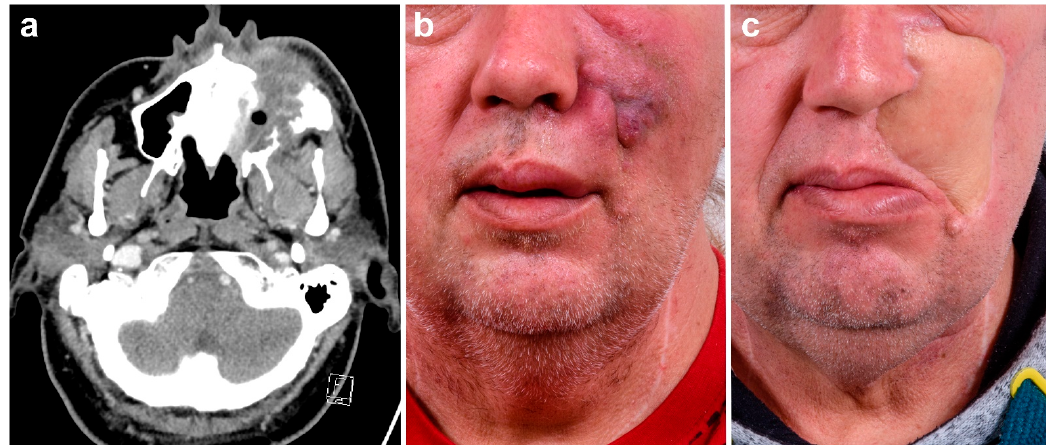
Figure 3. Male patient with recurrent squamous cell carcinoma of the left-sided maxilla with infiltration of the maxillary sinus and facial skin. ( a ) CT scan depicting the infiltration of the paranasal sinus and the facial skin. ( b ) Full-frontal image of the preoperative situation with tumor progression of the left cheek. ( c ) Full-frontal image of the postoperative situation after full-thickness tumor resection and reconstruction with ALT